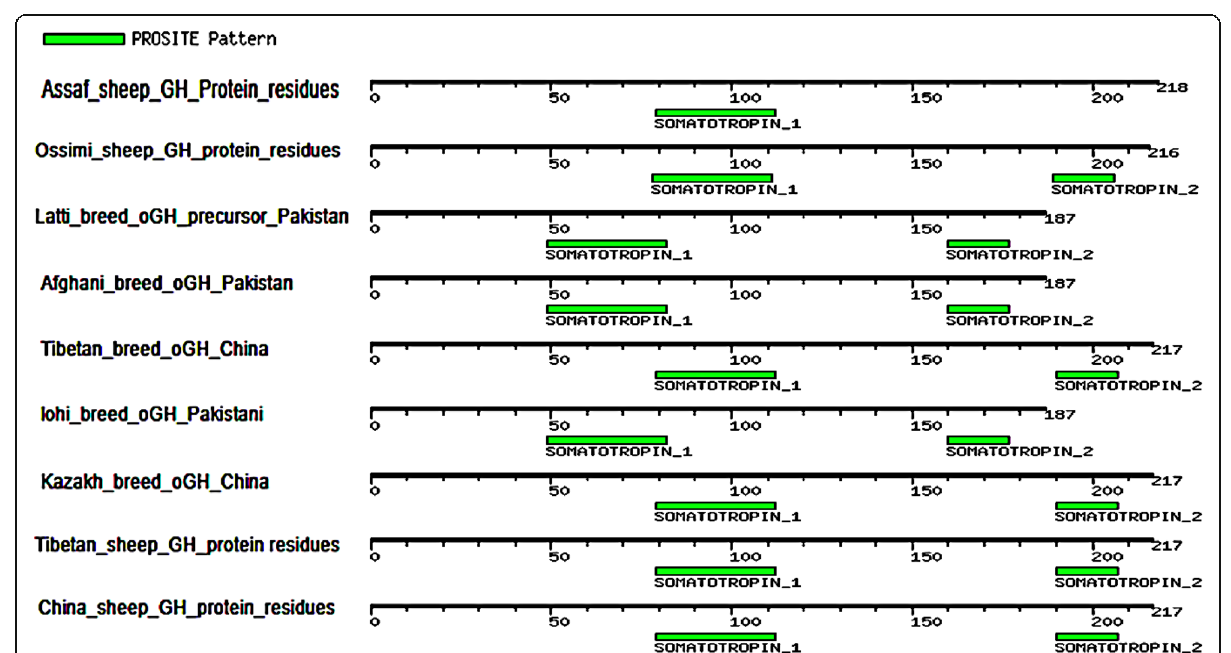
Fig. 14 Motif patterns of As_GH protein sequence compared with GenBank database